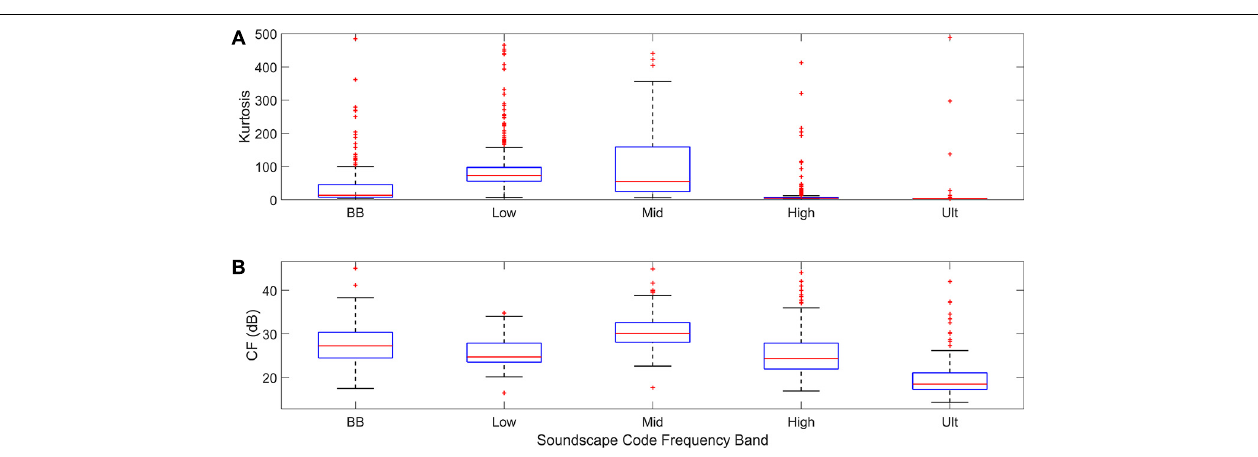
FIGURE 4 | Impulsiveness comparison I1 results for (A) kurtosis and (B) crest factor. Wherein the boxplots red horizontal line indicates median value, outer edges of boxes represent 25th and 75th percentiles, whiskers mark boundary that contains approximately 99% of data values, and the red points are